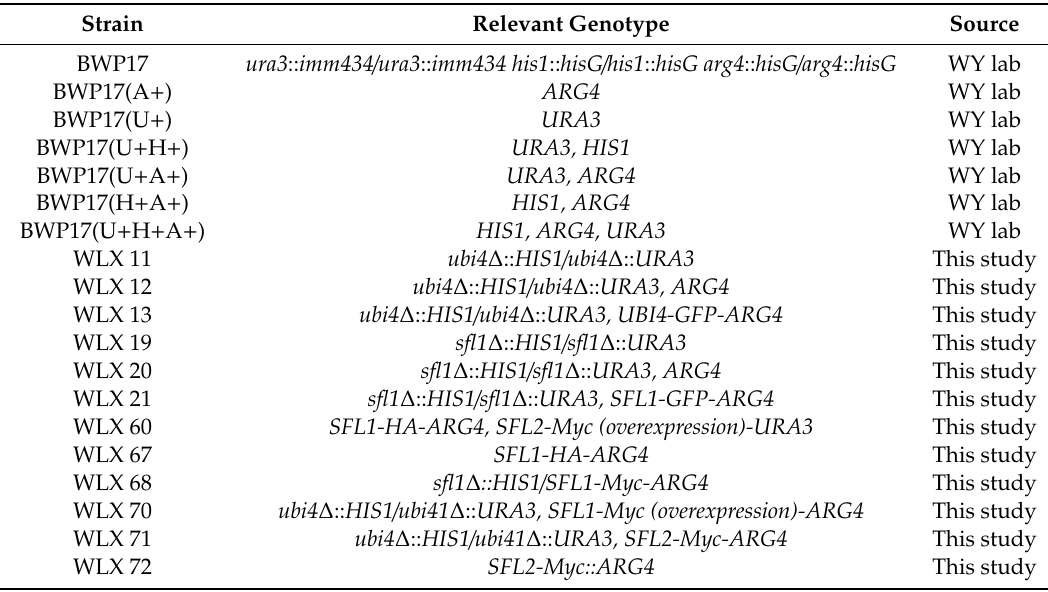
Table 1. C. albicans strains used in this